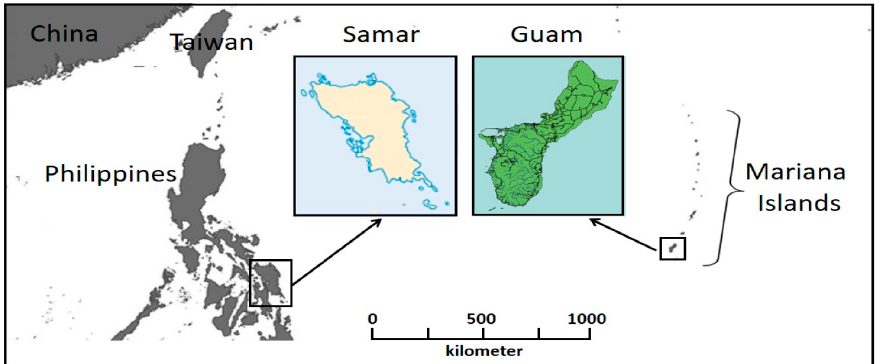
Figure 1. The islands of Guam and Samar served as source localities for Serianthes rhizosphere soils.